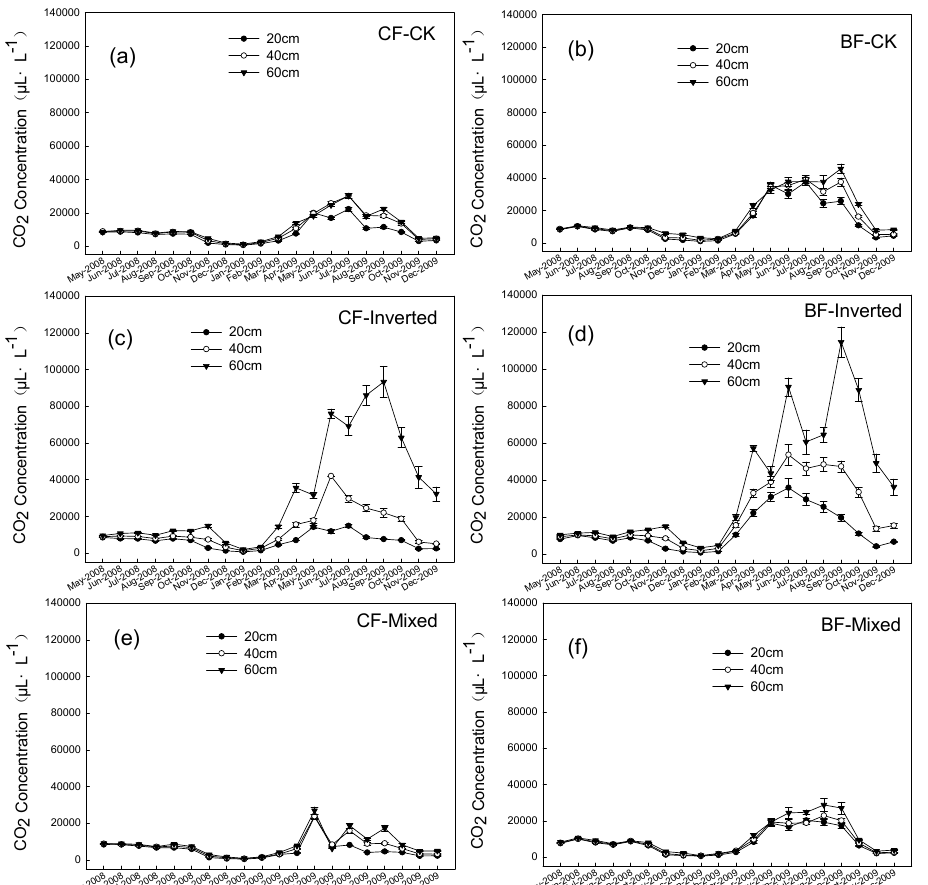
Figure 1. Seasonal variations of CO 2 concentration along soil profiles in a coniferous forest (CF) and a broad-leaved forest (BF). Different soil column treatments were: ( a ) CF-CK (upright soil column); ( b ) BF-CK; ( c ) CF-Inverted; ( d ) BF-Inverted; ( e ) CF-Mixed; and ( f ) BF-Mixed. Data are shown as means ± SE, n = 6.